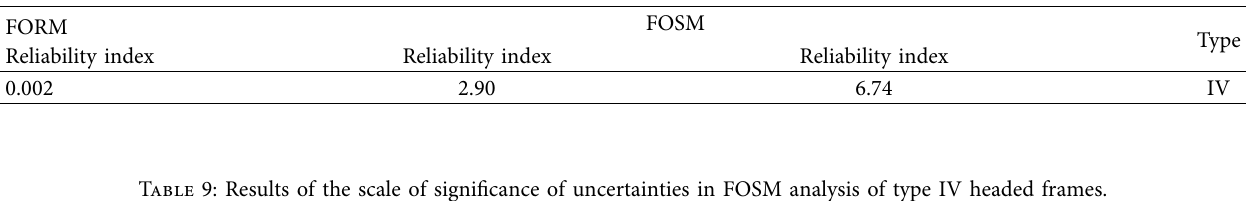
Table 8: Results of reliability analysis of four-story steel frame with RT program.